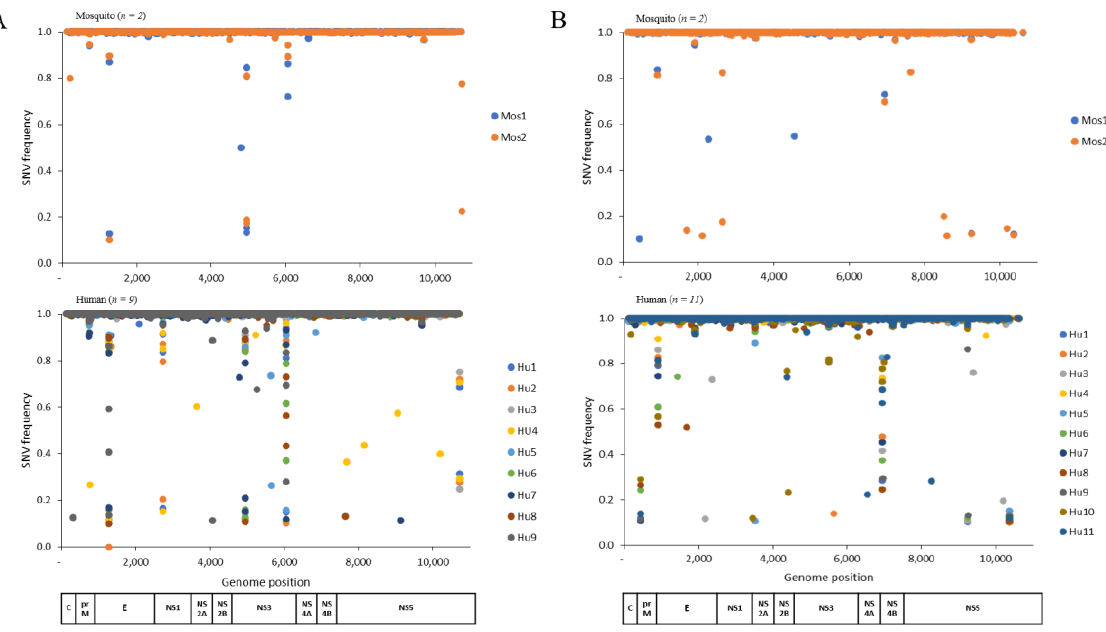
Figure 1. Intrahost genetic diversity of DENV. The variant frequency is plotted on the y-axis for DENV-1 ( A ) and DENV-4 ( B ), with genome position on the x-axis. This analysis was completed for each host type: humans (Hu) and mosquitoes ( Ae. aegypti Mo). C: capsid, prM: precursor membrane,